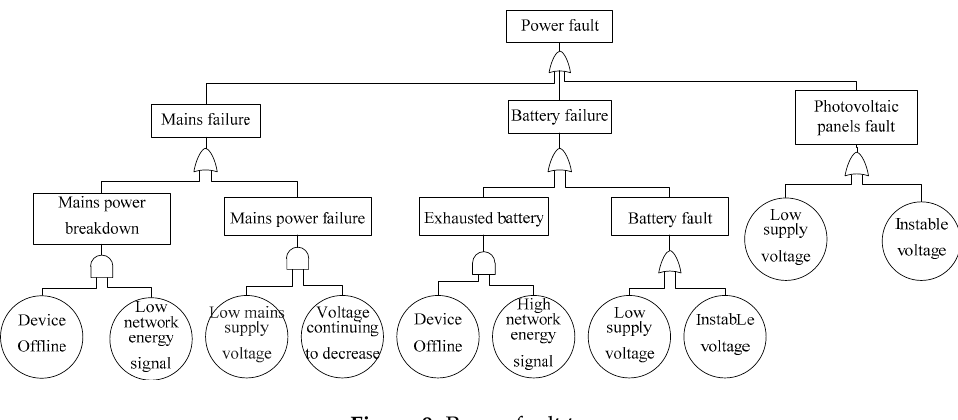
Figure 9. Power fault tree.